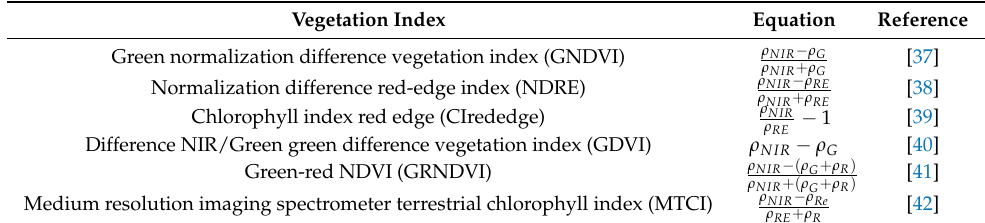
Figure 3. Average reflectance for each spectral band depending on the nitrogen fertilization treatment: ( a ) 2018, ( b ) 2019, and ( c ) 2020.